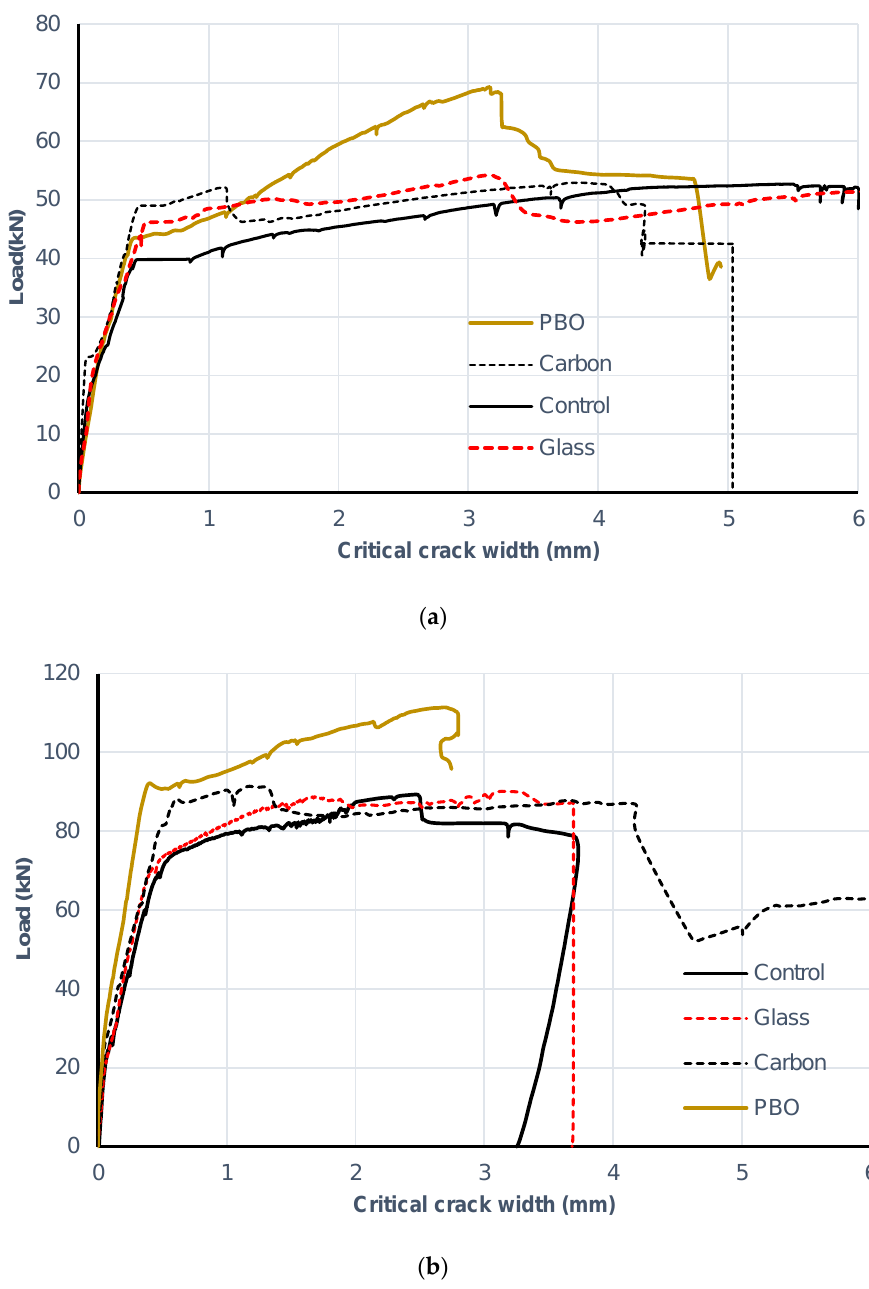
Figure 17. Load vs. critical crack width curve: ( a ) Group I; ( b ) Group II.